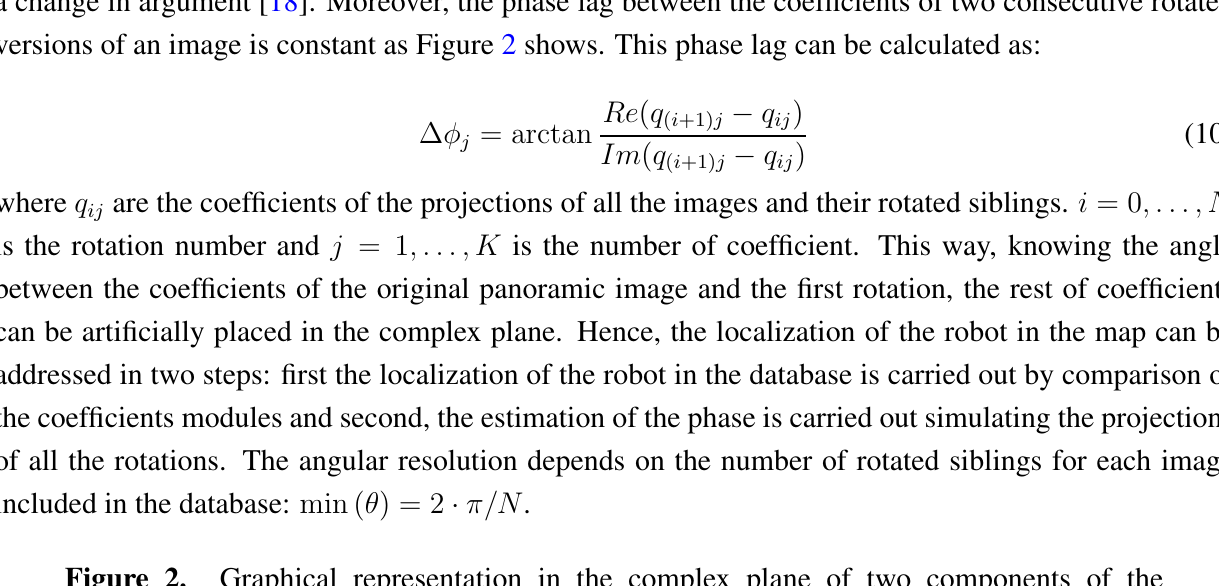
Graphical representation in the complex plane of two components of the projections of a 32 rotations set for an